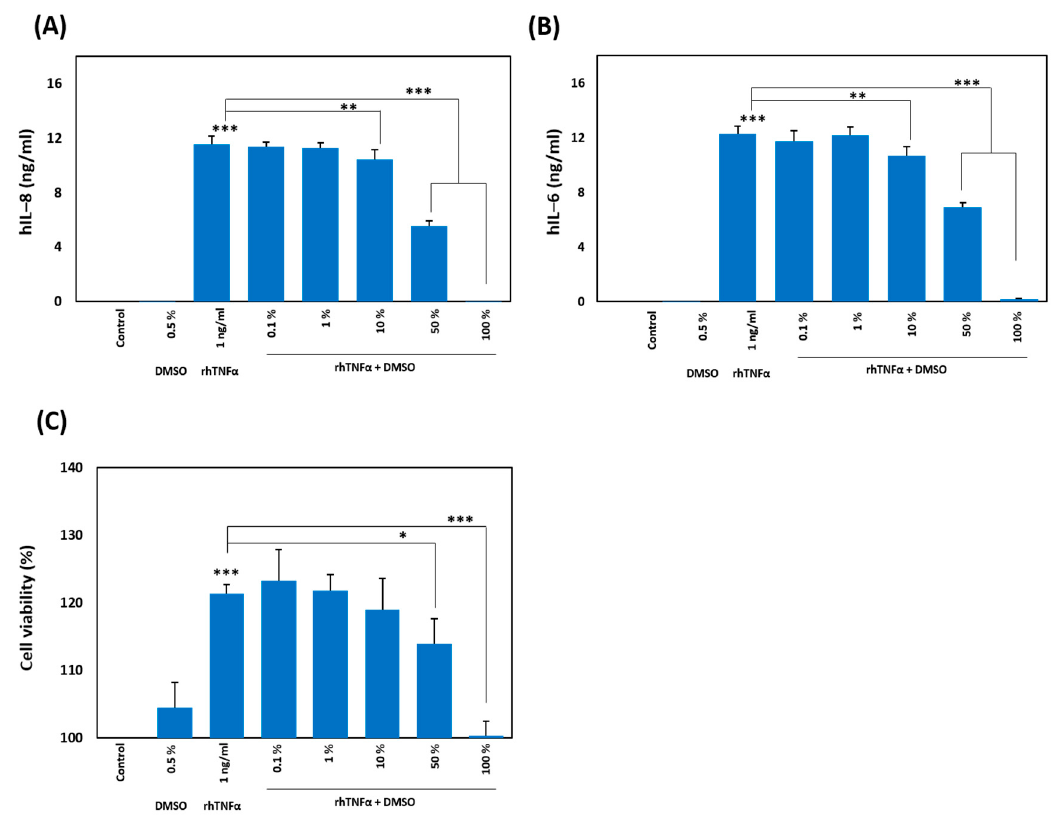
Figure 1. Tumor necrosis factor-alpha (TNF- α )-induced cytokine secretion and proliferation. ( A , B ) Human dermal fibroblasts (HDFs) (10 4 /well) were treated for 24 h with either recombinant human TNF- α (rhTNF- α ; 1 ng/mL) only or the indicated concentrations of dimethyl sulfoxide (DMSO)